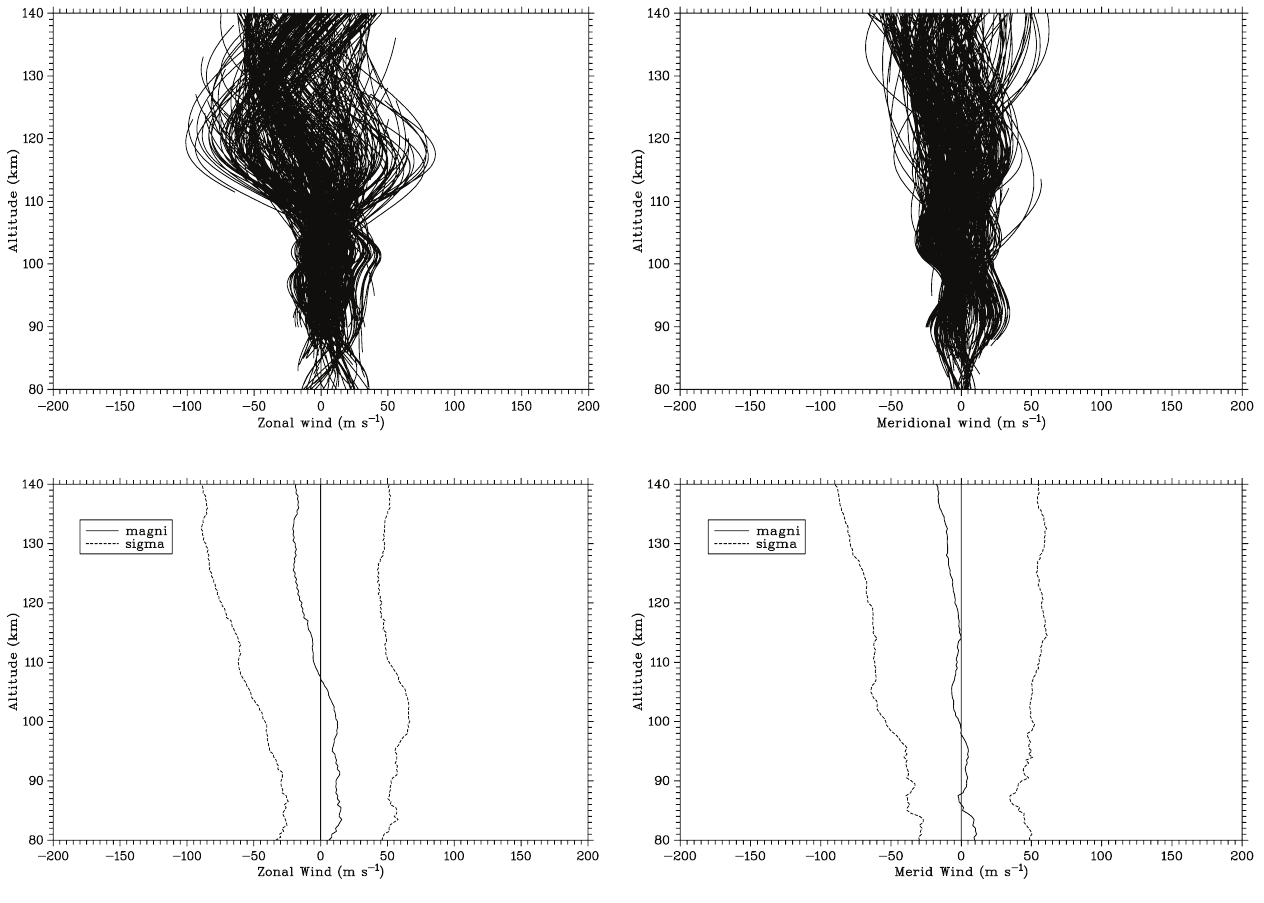
Fig. 4. Zonal (left panel) and meridional (right panel) HWM wind components for the profiles shown in Fig. 3 are shown in the top panels. The curves in the lower panels show the mean and standard deviations for the chemical release wind